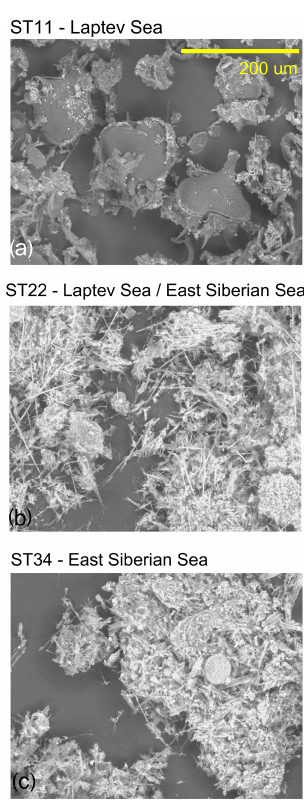
Figure 5. SEM images. (a) ST-11: dinoflagellates ( Protoperi- dinium spp.) in open waters of the Laptev Sea. (b) ST22: diatoms, mostly spines (setae) of Chaetoceros spp. in the transition between Laptev Sea and East Siberian Sea. (c) ST-34: diatoms from sea-ice- dominated waters in the East Siberian